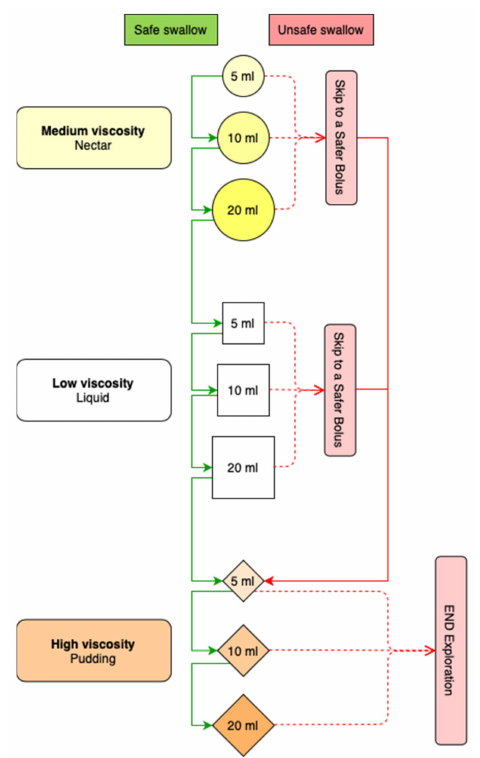
Figure 1. Algorithm of the volume-viscosity swallow test (V-VST). Patients with safe swallow start the test with a 5 mL medium bolus, followed by 10 and 20 mL, then perform with low viscosity following the same volumetric approach, and finally complete the test with high viscosity to explore the efficacy of swallow. If the patient presents any sign of impaired safety of swallow with any volume at medium or low viscosities, the procedure is interupted and the high viscosity is assessed. If there is any safety impairment with the high viscosity, the V-VST is ended. Green lines indicate a safe swallow, and red dashed lines indicate an unsafe